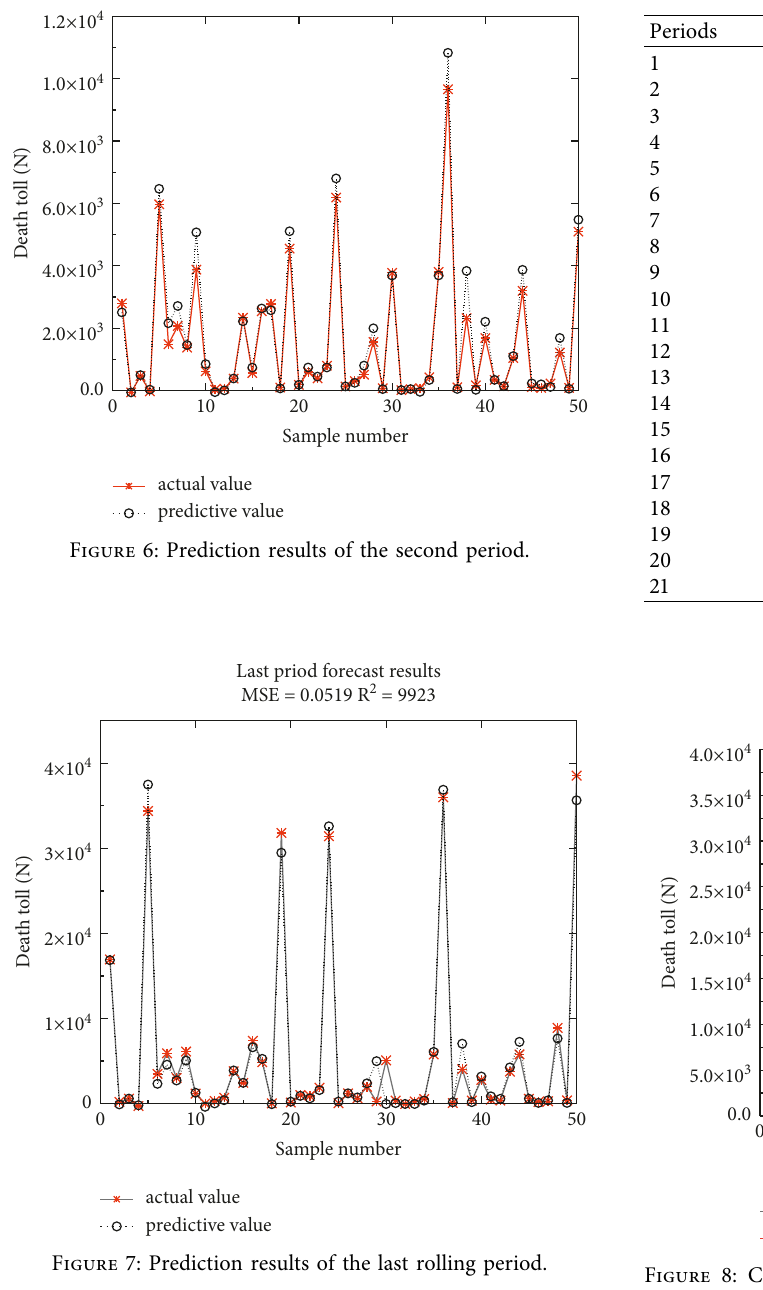
Table 9: Prediction accuracy of testing samples in the planning